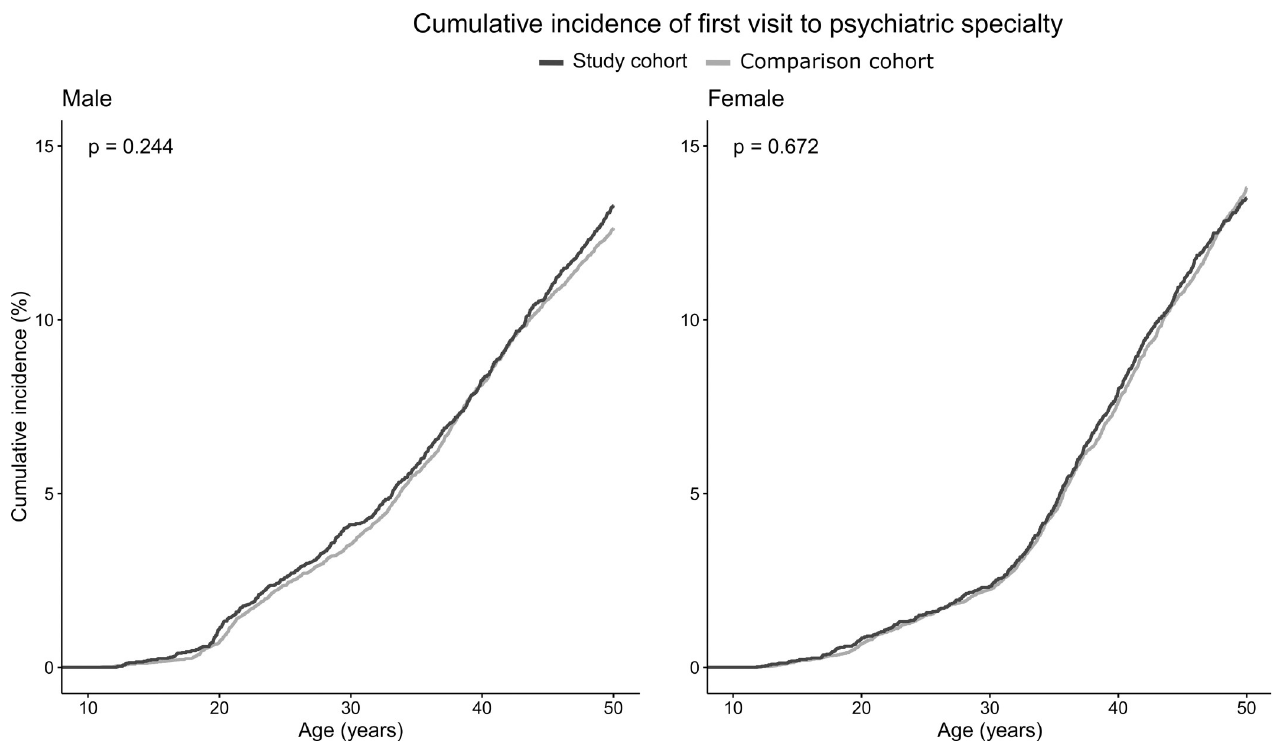
Fig 1. Kaplan-Meier curve for first visit to psychiatric specialty for study and comparison cohorts by sex with p-value from log-rank test.